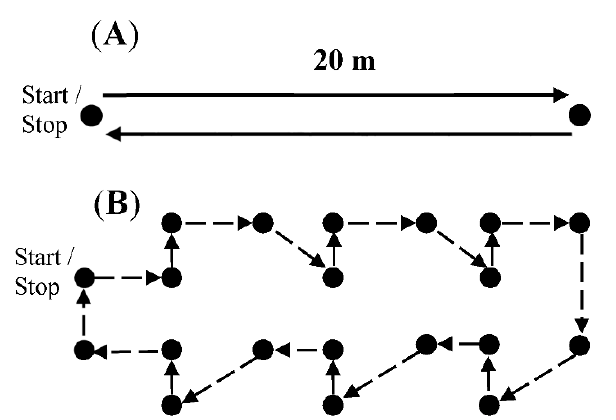
Figure 1. ( A ) Straight ahead walking. ( B ) Continuous turning. Each circle represents a cone and the direction of walking is shown by the arrows.